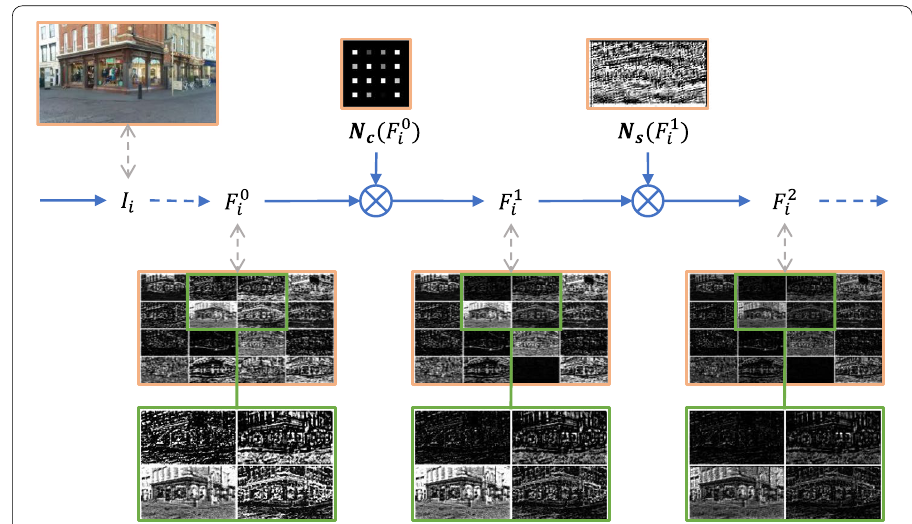
Fig. 7 Visualization of the feature maps of AttNet. Here N c ( F 0 i ) , N s ( F 1 i ) are feature maps of channel attention and spatial attention, respectively. Note we only show 16 channels out of 64